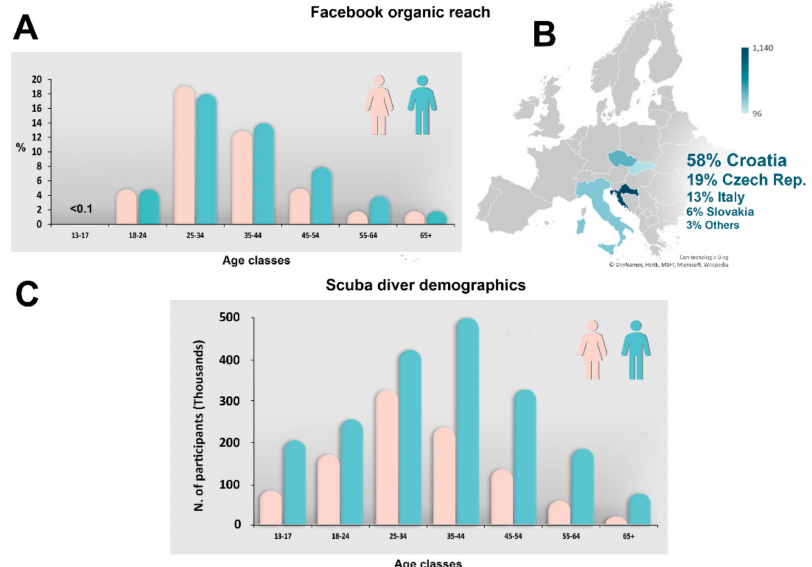
Figure 5. Comparison of demographics of ( A , B ) Facebook fans and ( C ) scuba divers. ( A , B ) Facebook organic reach for ( A ) age, sex and ( B ) place of origin; ( C ) demographics of participants to recreational scuba divers, from the divers alert network (DAN) Report